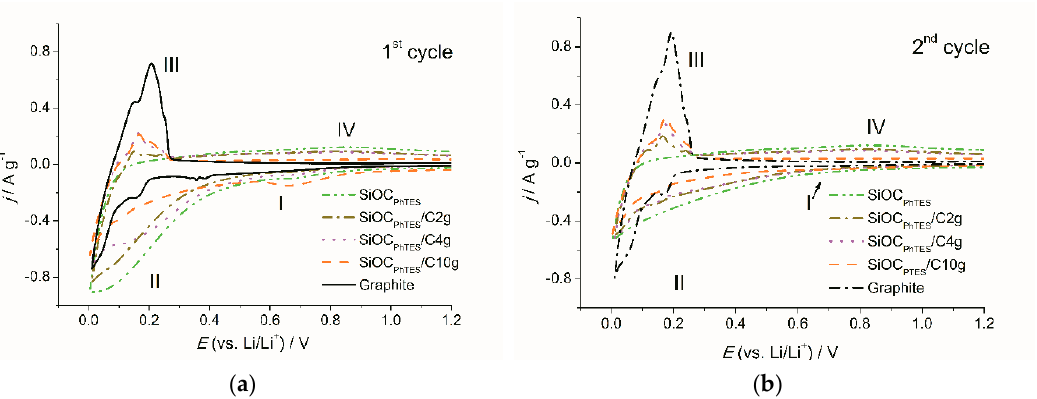
Figure 7. Cyclic voltammetry curves of the investigated materials: ( a ) first cycle, ( b ) second cycle; scan rate 0.1 mV s − 1 .